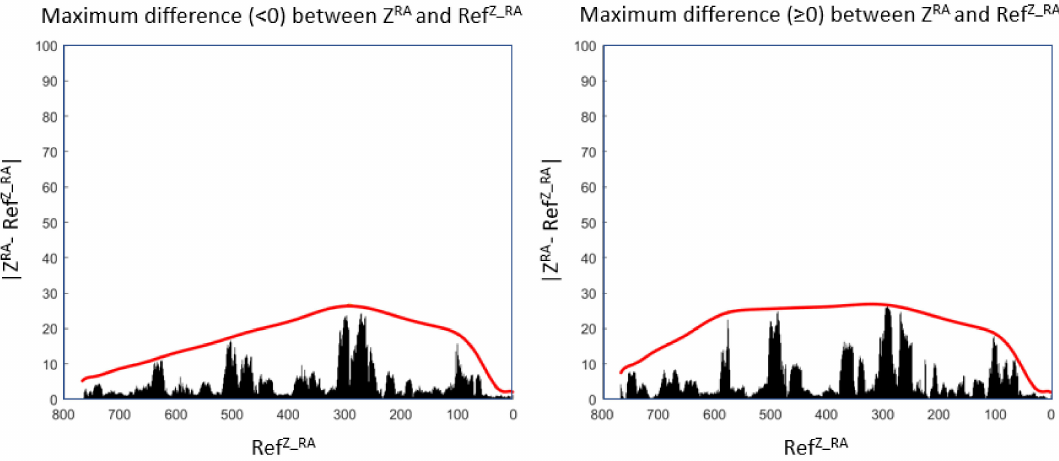
Figure 20. An envelope for the positive differences and another for the negative ones using real RA